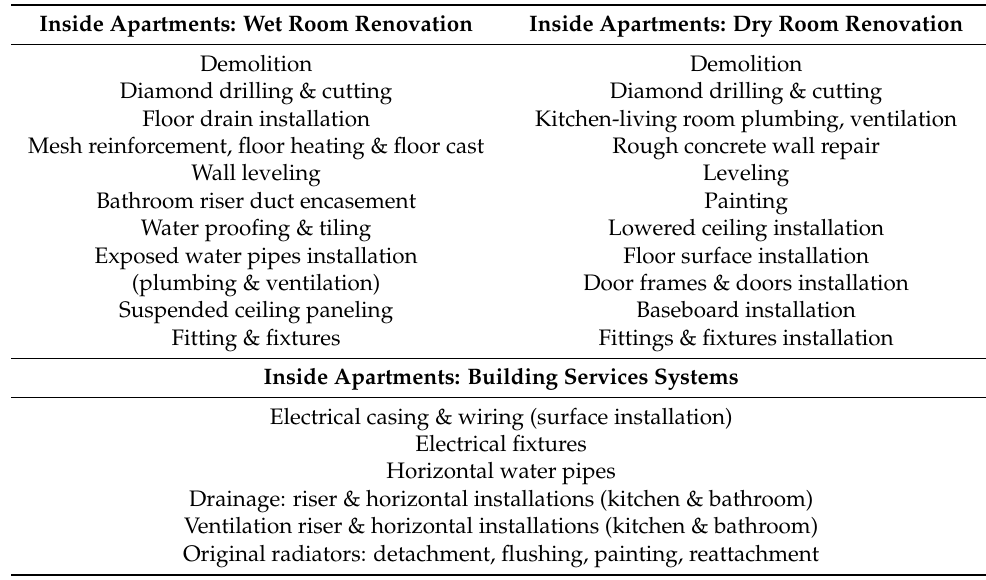
Table 1. Takt work in the apartments in the case